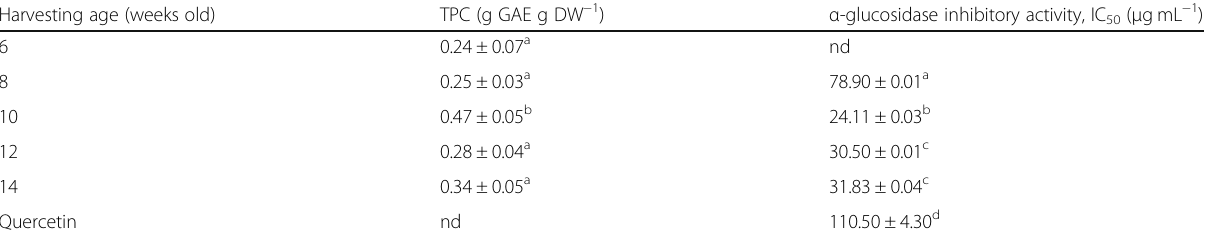
Different letters in a column indicate significant differences ( p <0.05) using Duncan ’ s test. Values are expressed as the mean±standard deviation (n=3). nd not